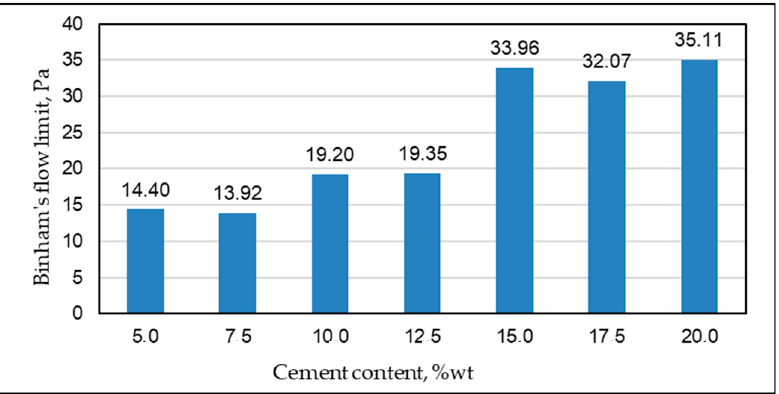
Energies 2023 , 16 , x FOR PEER REVIEW 8 of 23